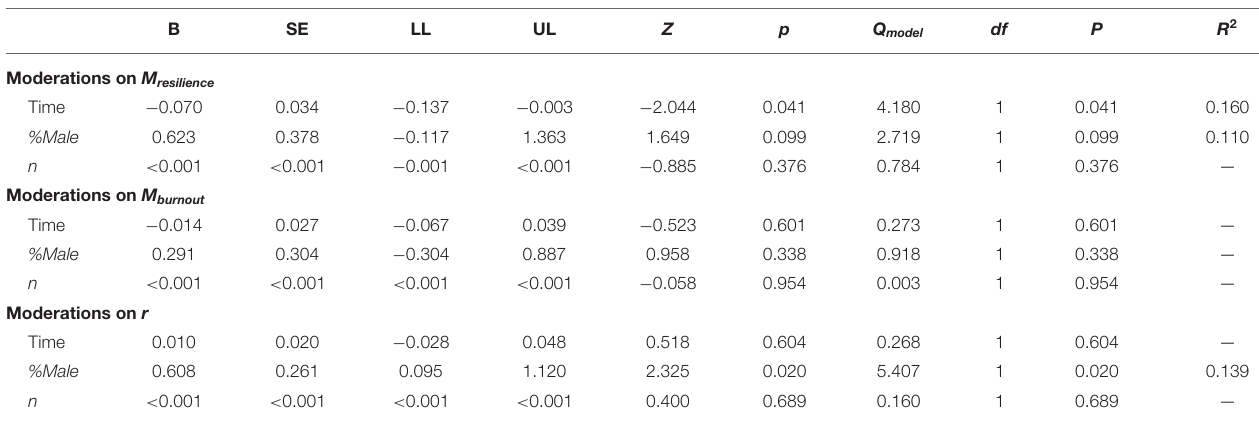
TABLE 7 | Mixed-effects regression (maximum